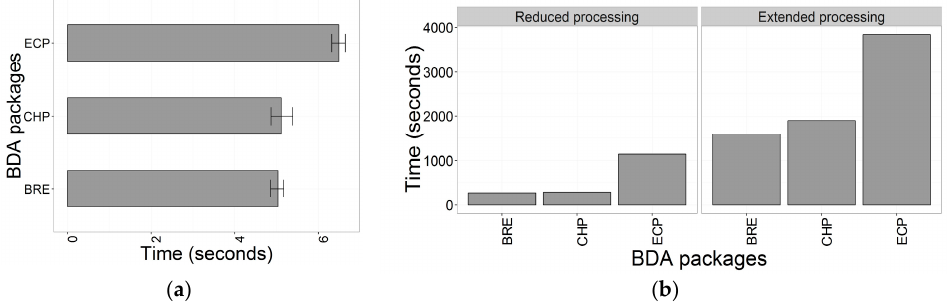
Figure 14. Execution time measured for: ( a ) Each BDAs optimized processing chain, running 10 times with a sample set of 100 pixels. ( b ) Total GA execution time obtained for each BDA package and approaches applied. Acronyms used for BDAs are: BRE for BreakoutDetection; CHP for Changepoint; and ECP for the package of the same name.